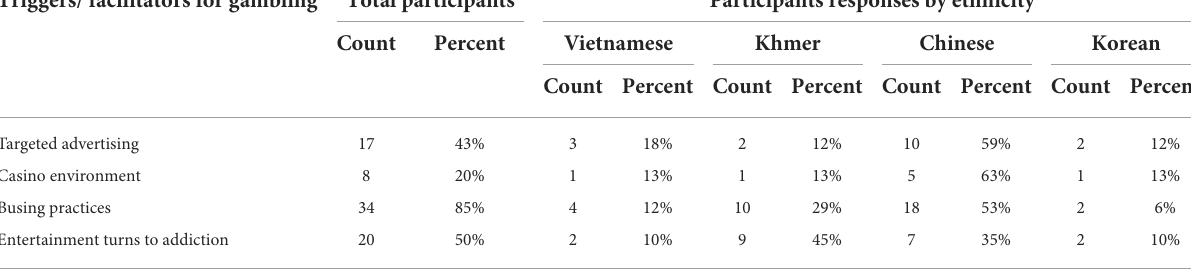
TABLE 3 Participants were asked about their thoughts and experiences on gambling in their communities and potential triggers or facilitators to gambling. Triggers/ facilitators for